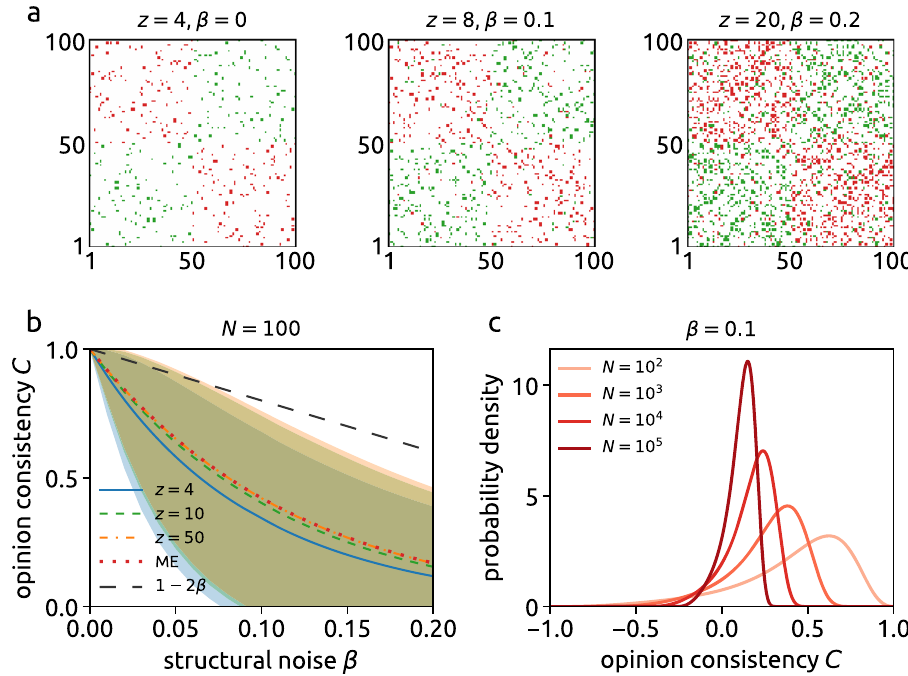
Fig. 2 Opinion formation on random relation networks with a two-camp structure. a Examples of adjacency matrices of regular random networks with a two-camp structure for 100 subjects and various values of node degree, z , and structural noise, β . Subjects 1 – 50 are from camp 1 and subjects 51 – 100 are from camp 2. The green, red, and white points represent positive, negative, and absent relations, respectively. b Resulting opinion consistency for N = 100 subjects, one seed opinion, and various values of z . The lines show mean values and the shaded regions show the 10th – 90th percentile ranges (both computed from 1000 model realizations for each of 1000 realizations of the relation network). The dotted line labeled ME shows the mean consistency computed by numerically solving the master equation given by Eq. (3). The dark dashed line shows the expected consistency if its relationship with the level of noise was linear [ C 0 ( β ) = 1 − 2 β ]. These results demonstrate that consistency decreases quickly with structural noise. c The consistency distributions obtained using Eq. (3) for β = 0.1, one seed subject, and a growing number of subjects, N . As N increases, the distributions shrink and their peaks shift toward